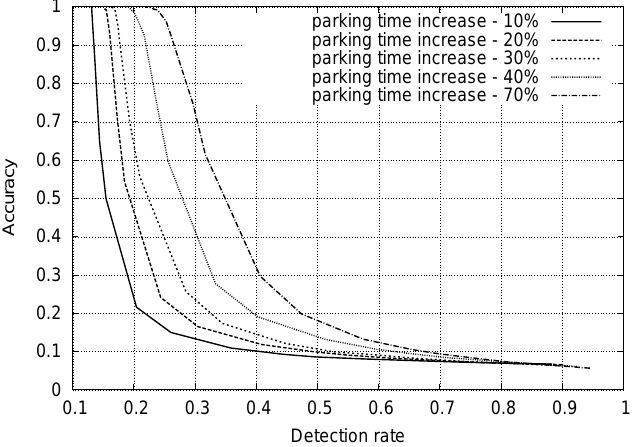
Figure 3. Anomaly detection: accuracy vs. detection rate: month of January 2015. Different curves correspond to specific increases in the parking times, from 10% to 70% for 20% of the parking